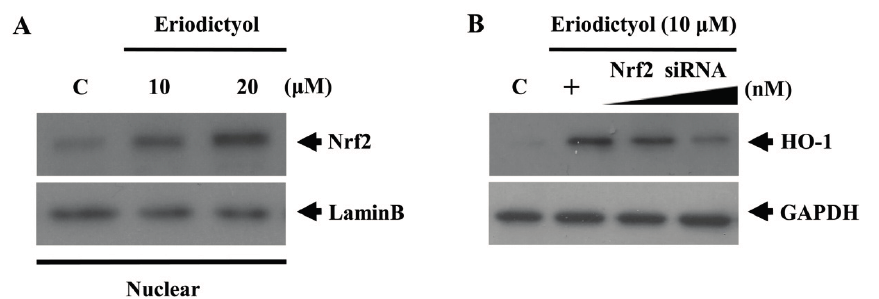
Figure 5. Nrf2 nuclear translocation induced by eriodictyol. ( A ) Cells were treated with 10 and 20 μ M eriodictyol at the indicated concentrations for 4 h. Nuclear extracts were subjected to Western blot, using an anti-Nrf2 antibody and anti-lamin B antibody (a marker of nuclear protein); and ( B ) Transient transfection of cells with increasing doses of Nrf2-specific siRNA (10 and 20 nM) reduced HO-1 expression. Western blots representative of three independent experiments are shown: C, untreated cells; +, eriodictyol treatment